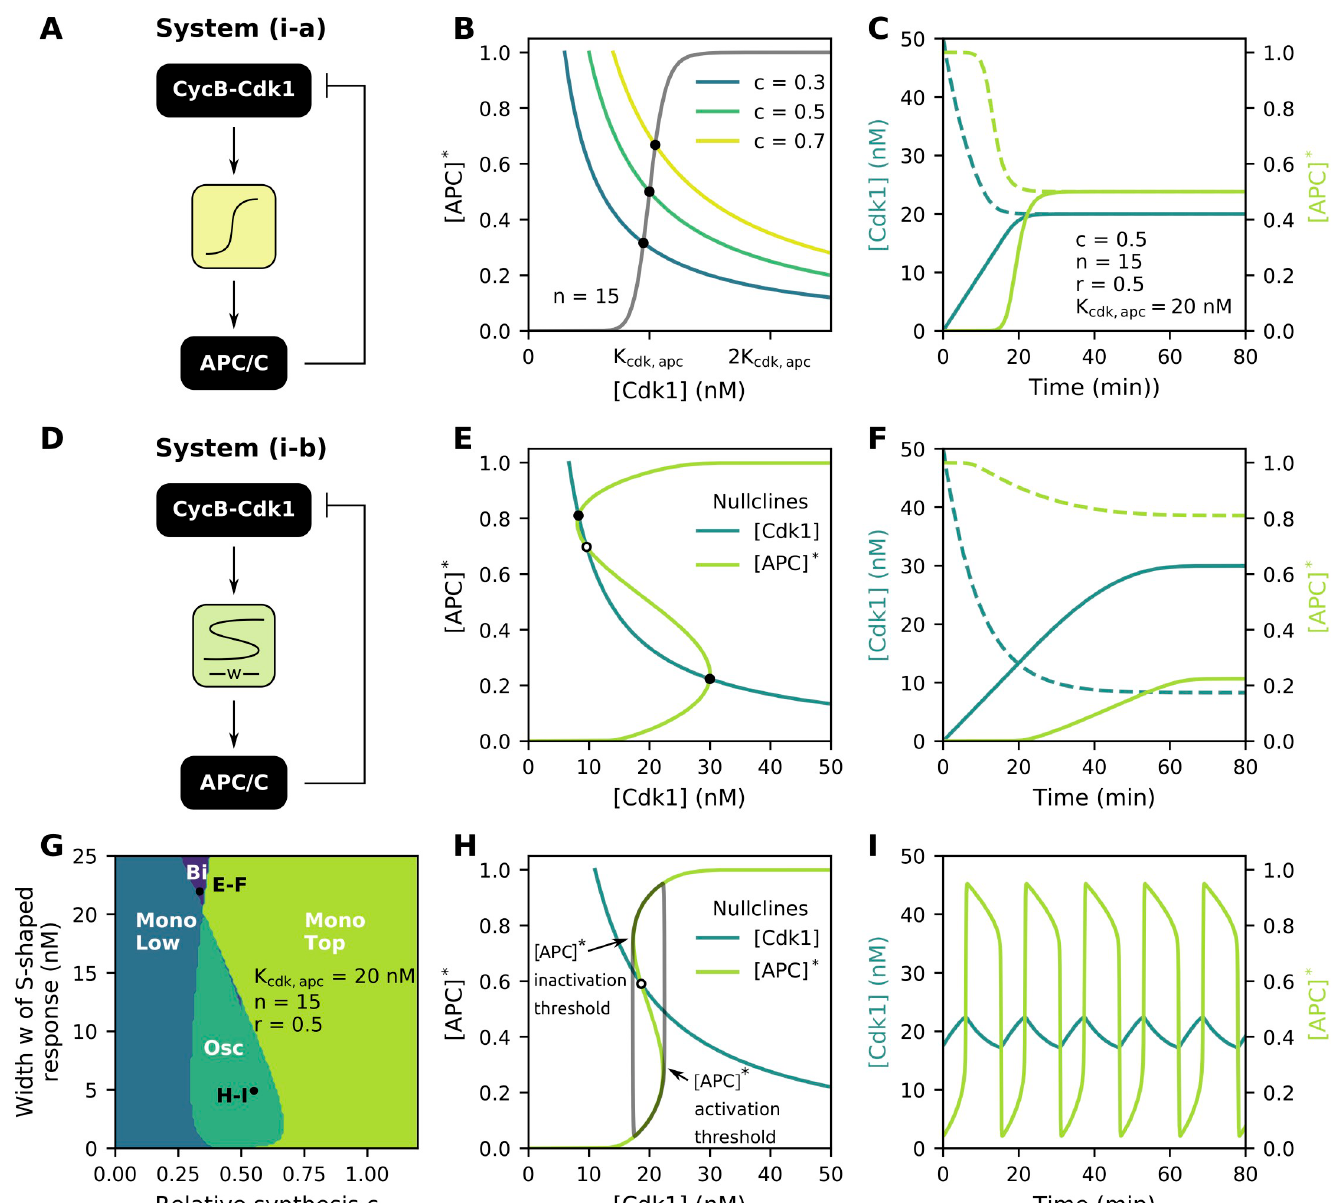
Fig 3. S-shaped, but not ultrasensitive, responses cause a two-dimensional system of the cell cycle to oscillate. Parameter values as indicated in the figure. (A) Block diagram of the ultrasensitive, negative feedback system (i-a). (B) Effect of relative synthesis c on the location of the [Cdk1] nullcline in the phase plane. (C) Time traces for two different initial conditions of system (i-a), denoted by either continuous or dotted line. Only one steady state exists. (D) Block diagram of the bistable, negative feedback system (i-b). (E) For wide S-shaped [APC] � nullclines, three intersections in the phase plane can exist, resulting in bistability of the overall ODE system. Closed black dots depict stable steady states, while open dots denote unstable steady states. (F) Time traces for system (i-b). Depending on the initial conditions, the system will settle in one of two stable steady states. (G) Number and position of the steady states for system (i-b). Osc = oscillations, Bi = bistable, Mono Low = one stable steady state on lower branch of [APC] � nullcline, Mono Top = one stable steady state on top branch of [APC] � nullcline. (H-I) If the [Cdk1] nullcline intersects the [APC] � nullcline in between its folds, one unstable steady state exists, resulting in oscillations.